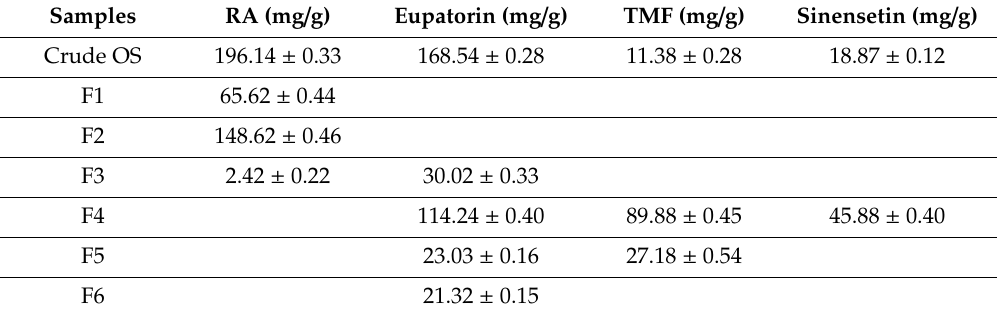
Concentration of biomarkers collected for each fraction and crude extract. TMF,